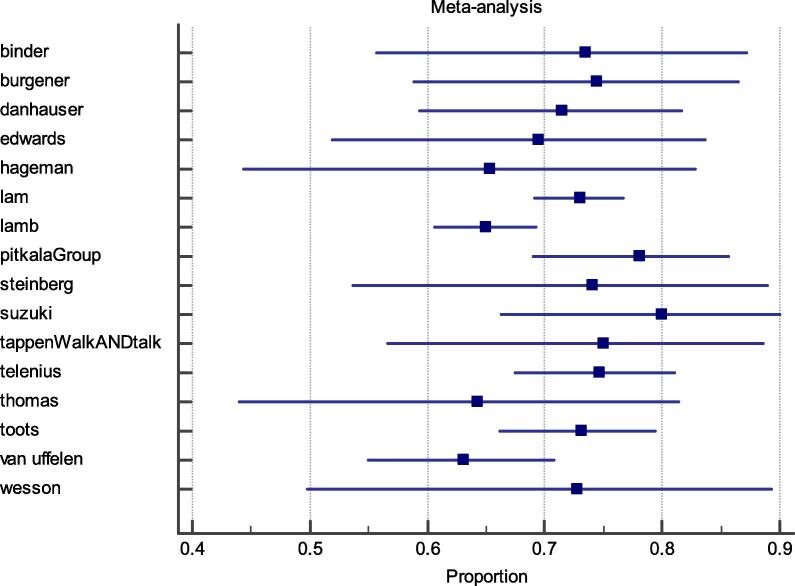
Studies included in meta-analysis on adherence rates at the end of the intervention NOTE: The value for Pitkälä15 refers to adherence of participants to the group, as opposed to the individual intervention; the value for Tappen82 refers to the adherence of participants to the walking plus conversation, as opposed to the walking only intervention.